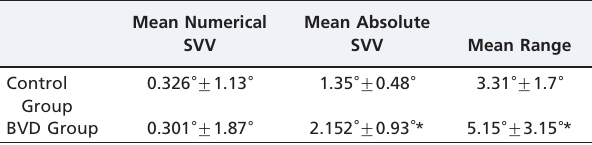
Table 2 - Differential analysis of the mean SVV values: numerical value, absolute value and the range of